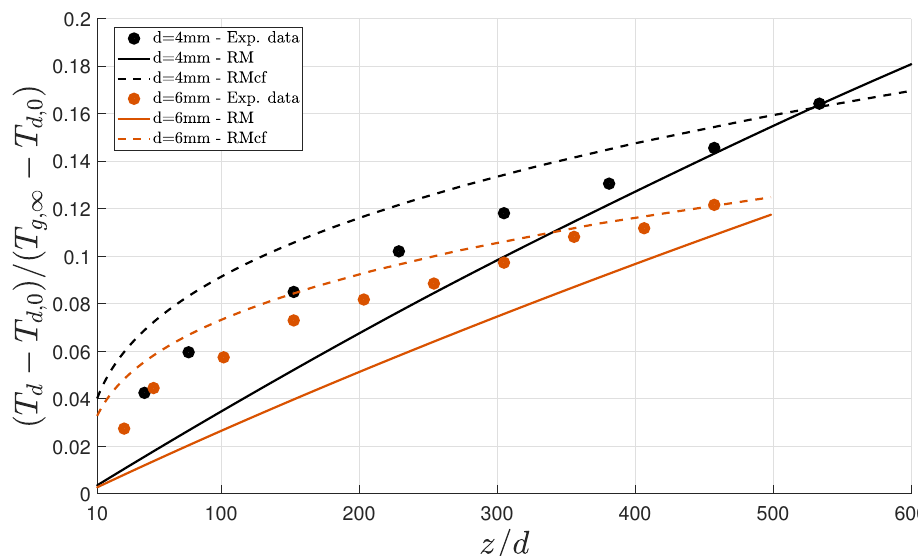
Figure 5. Variation in the temperatures of single water droplets falling through the air, subjected to a humidity ratio of 0.52.